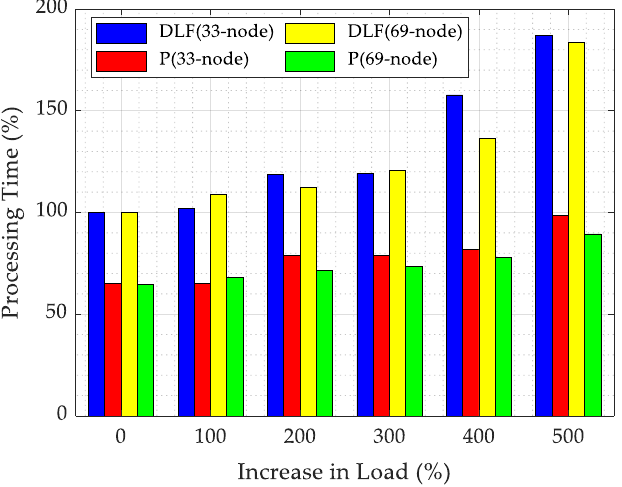
Figure 10. Solution time of the proposed and direct load flow (DLF) methods.